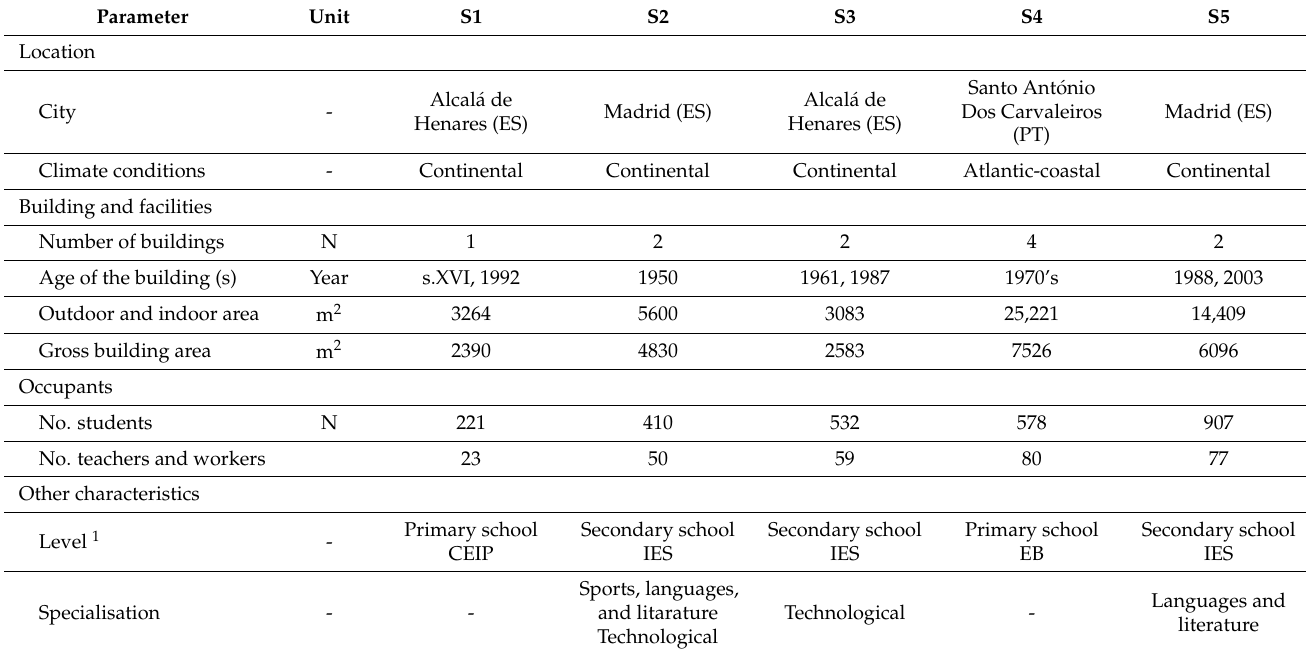
Table 5. Location and technical data of the